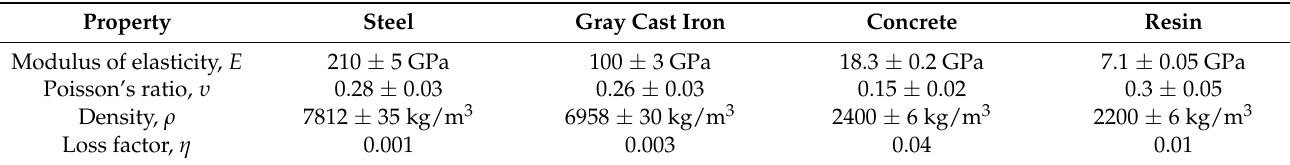
Table 1. Properties of materials included in the analyzed structure.